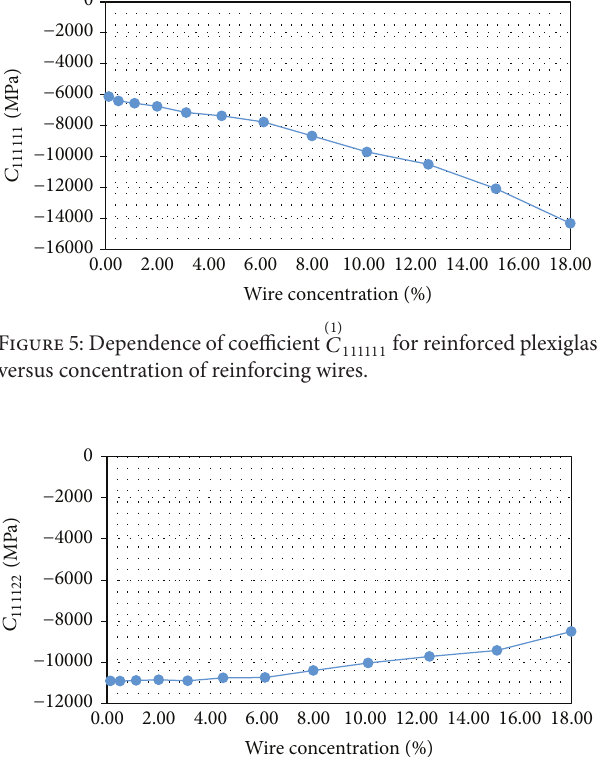
Figure 6: Dependence of coefficient versus concentration of reinforcing